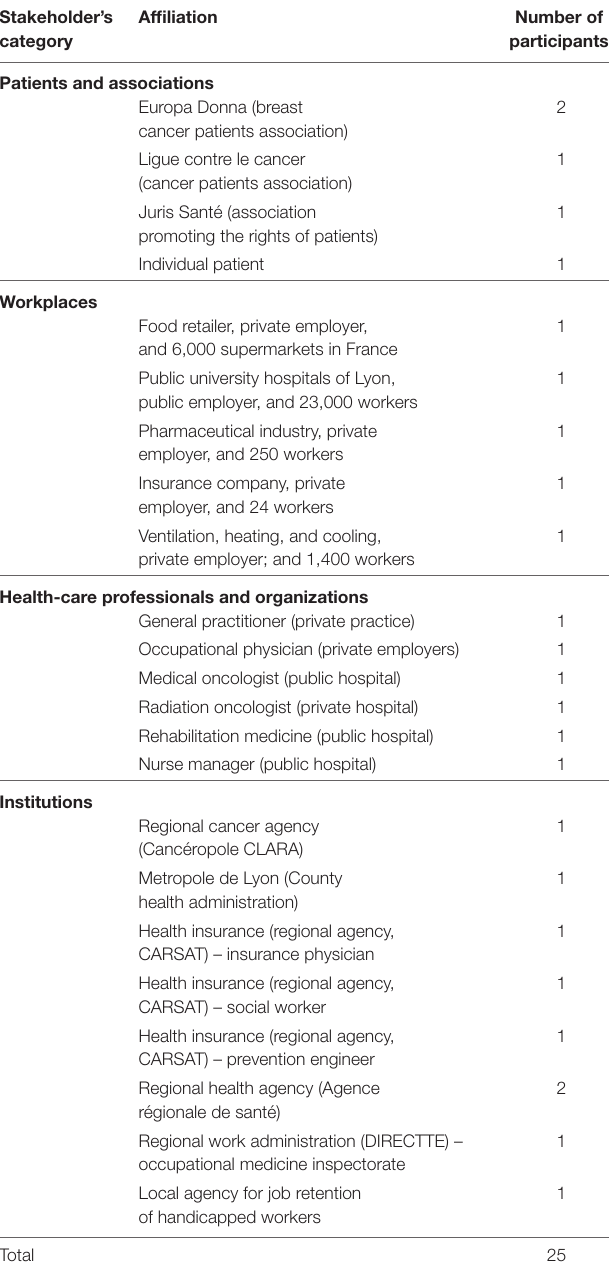
TaBle 2 | Composition of the planning group. stakeholder’s